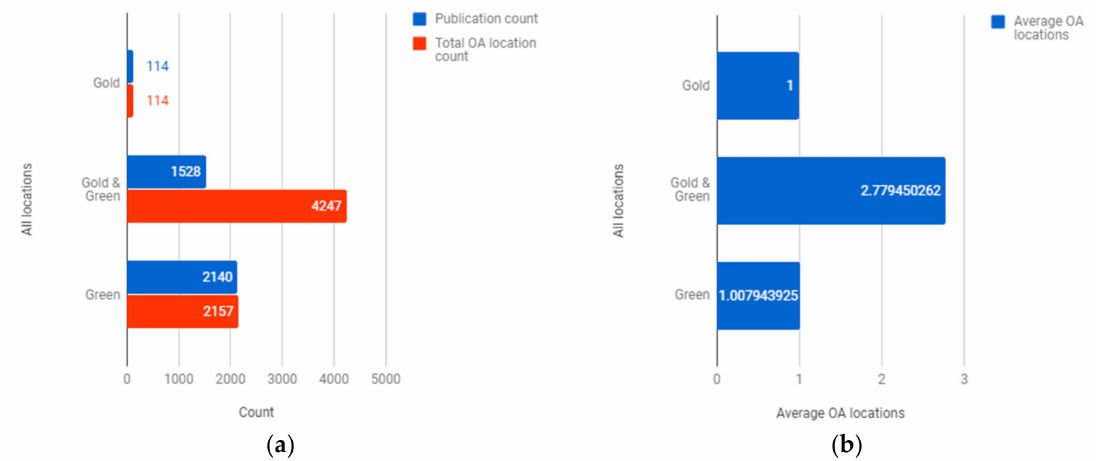
Figure 6. The total OA locations (‘All location’ classification) 2014–2017, ( a ) total OA locations; ( b ) average OA locations.